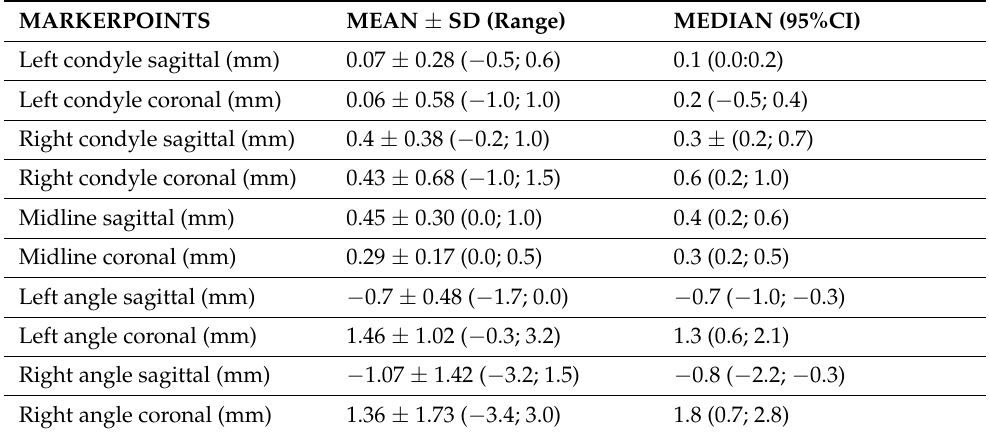
Table 1. Mean and median values of difference (in mm) between pre-operative and post-operative position of every mandibular marker point, measured on TC images.